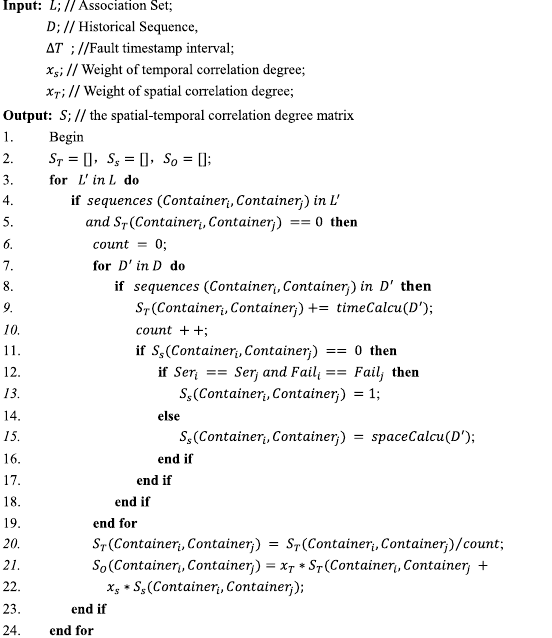
Algorithm 1. Calculate the Spatial-temporal Correlation Degree of Faults Among Containers